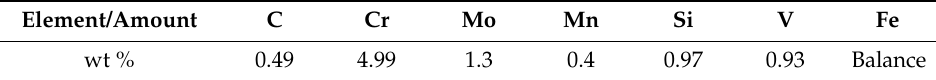
Table 1. Chemical composition of AISI H13 used as die cast mold substrate.